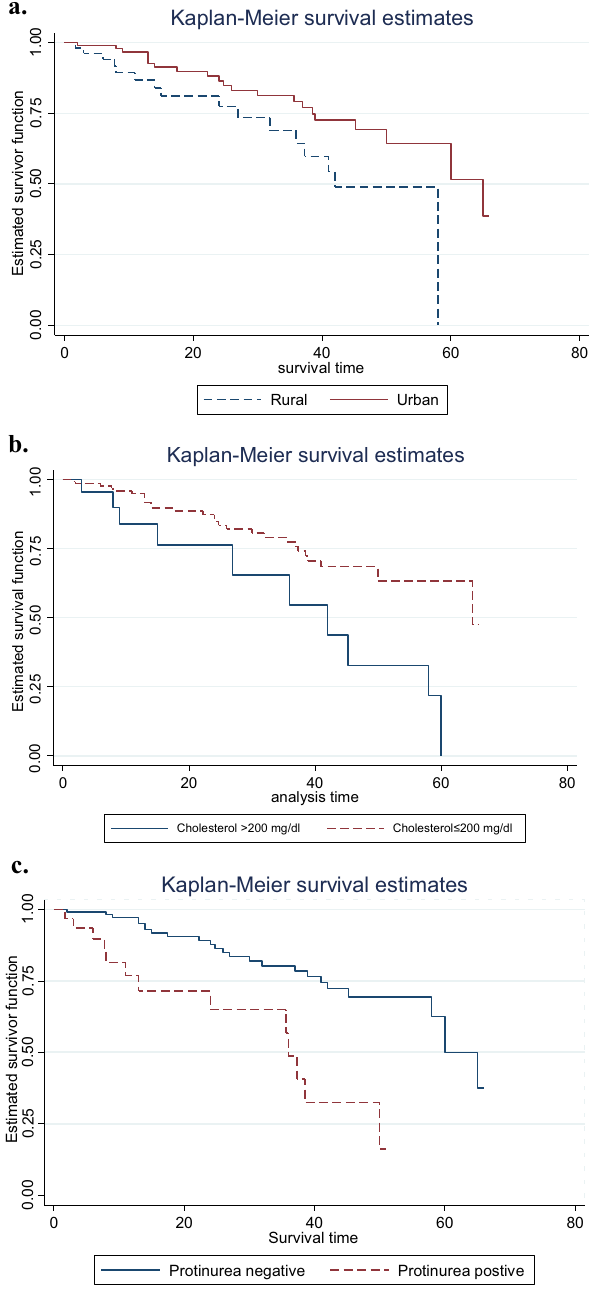
Figure 1. (a–c) Plots of Kaplan–Meier survival functions of categorical variables among T2DM Patients under Anti diabetes treatment at FHRH, December 2011–March